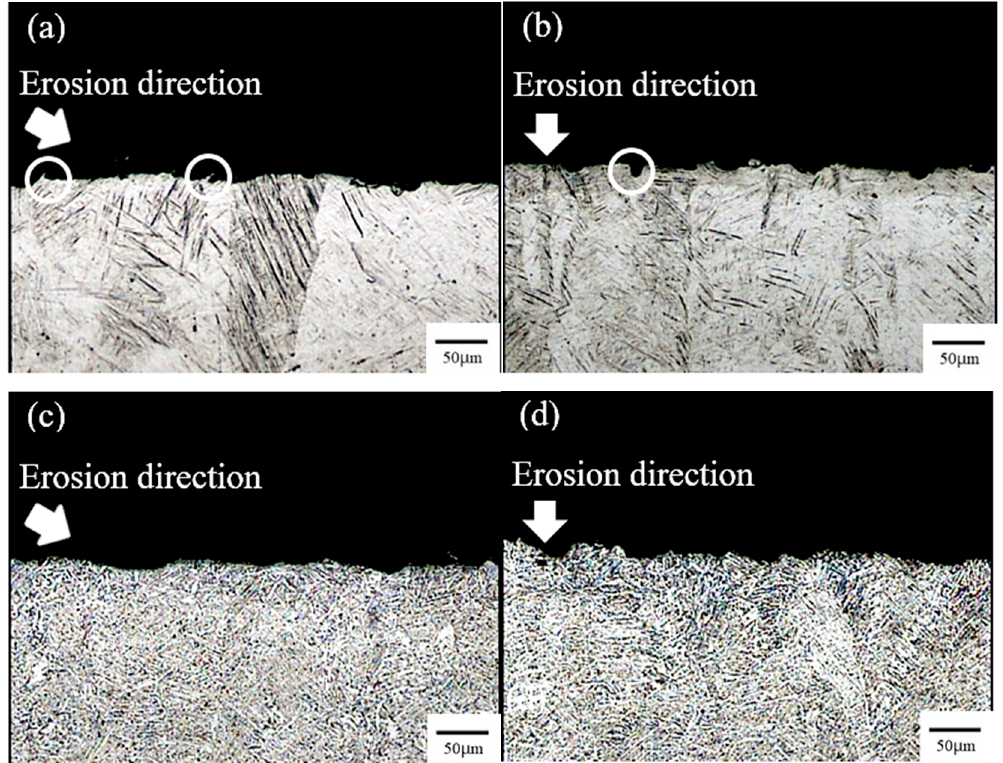
Figure 13. Subsurface morphologies of AS at ( a ) 30° and ( b ) 90°. Surface morphologies of 800-AC at ( c ) 30° and ( d ) 90°.